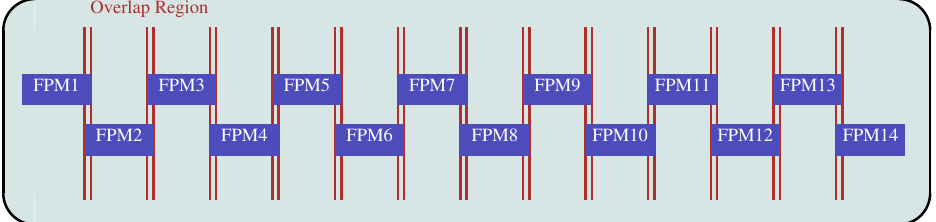
Figure 1. Operational Land Imager focal plane